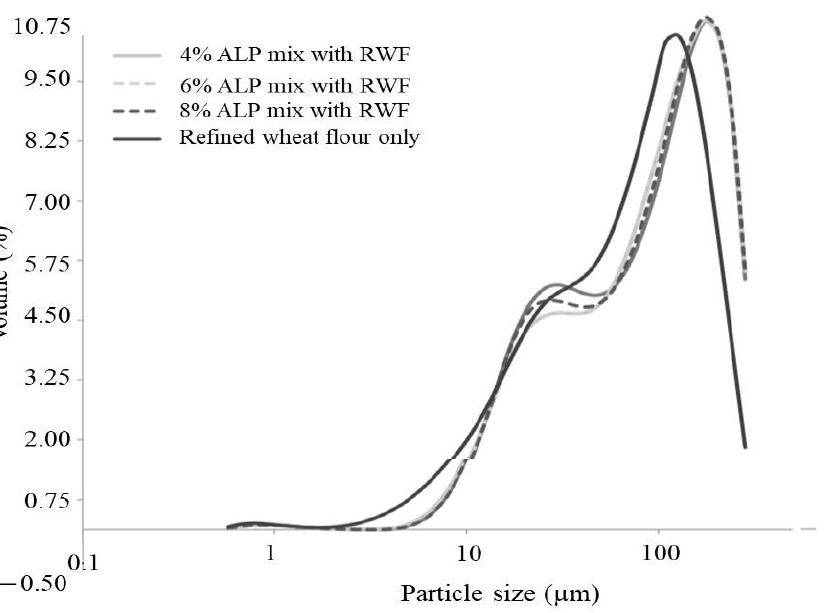
Figure 1. Particle size of mix flour (Aloe Vera powder and refined wheat flour) and refined wheat flour. The ALP supplemented cakes were analyzed for their nutritional composition (Table